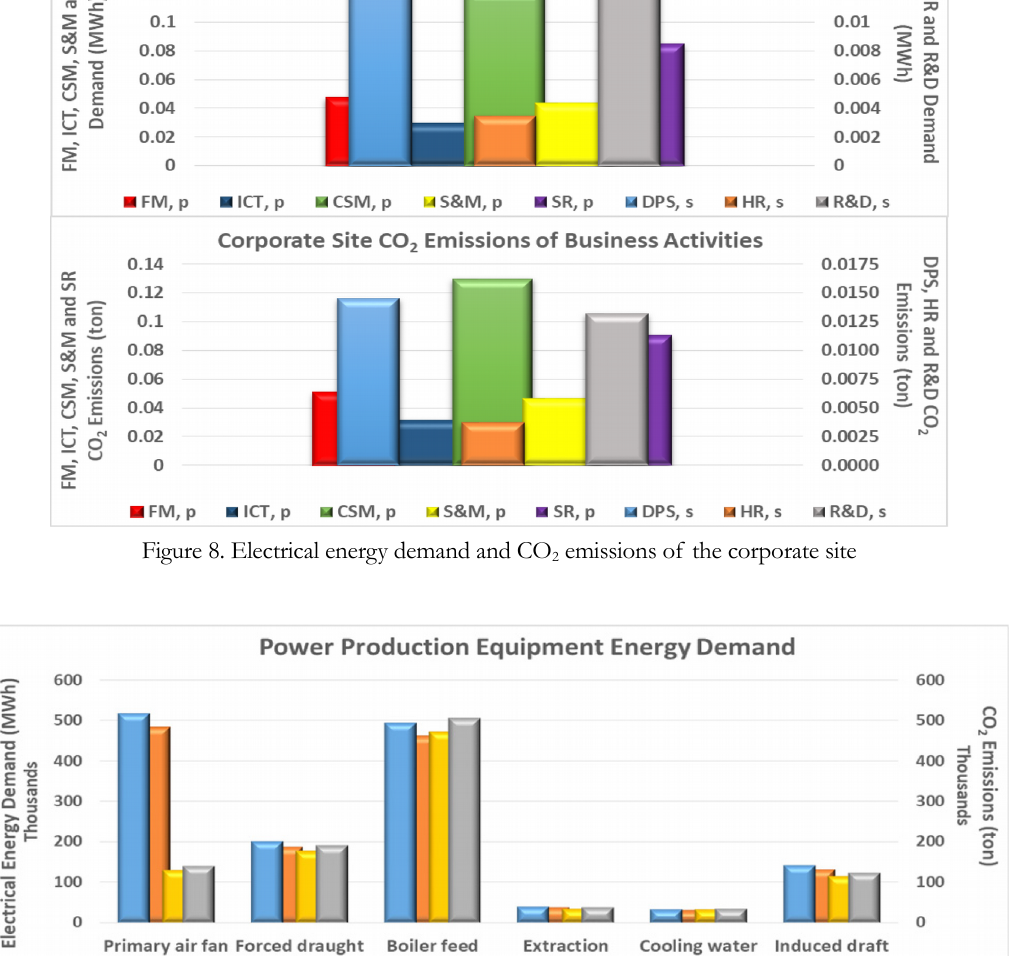
Figure 9. Equipment electrical energy demand of the steam generation